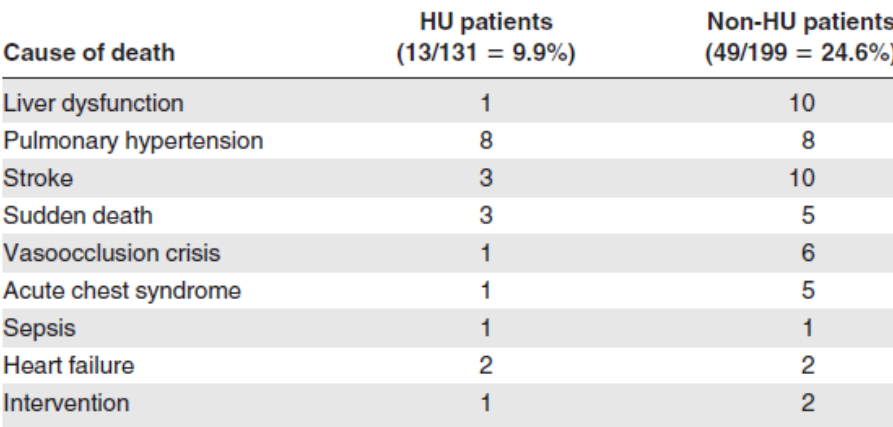
Figure 1. Causes of death in HU and non-HU patients (adapted from [10]).